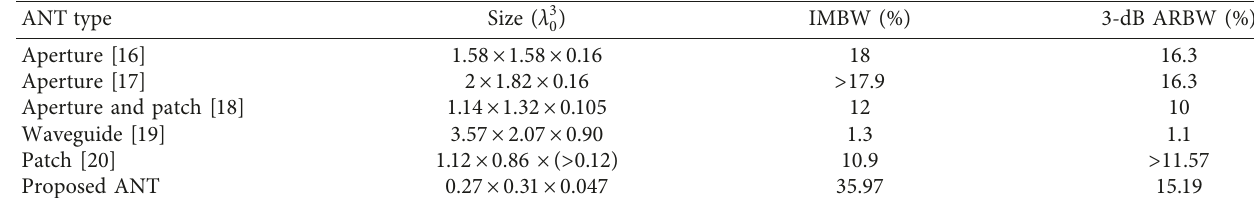
Table 2: Comparison of CP Antennas at